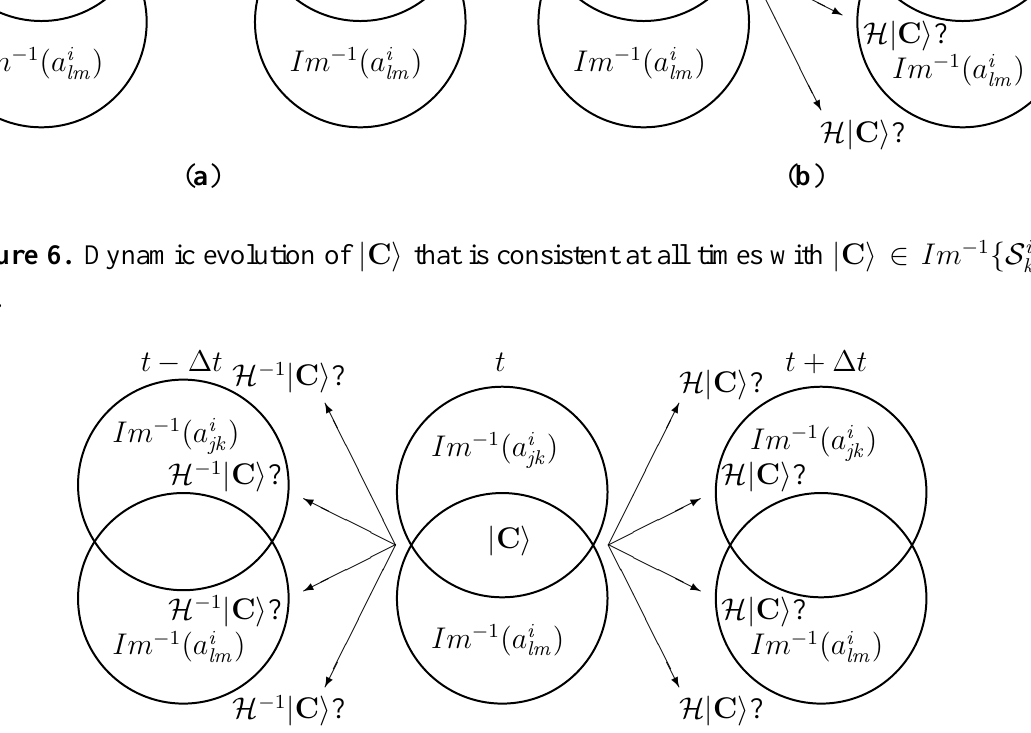
i i or jk lm A A C i i if [ , ] = 0 . jk lm H| i A A 6